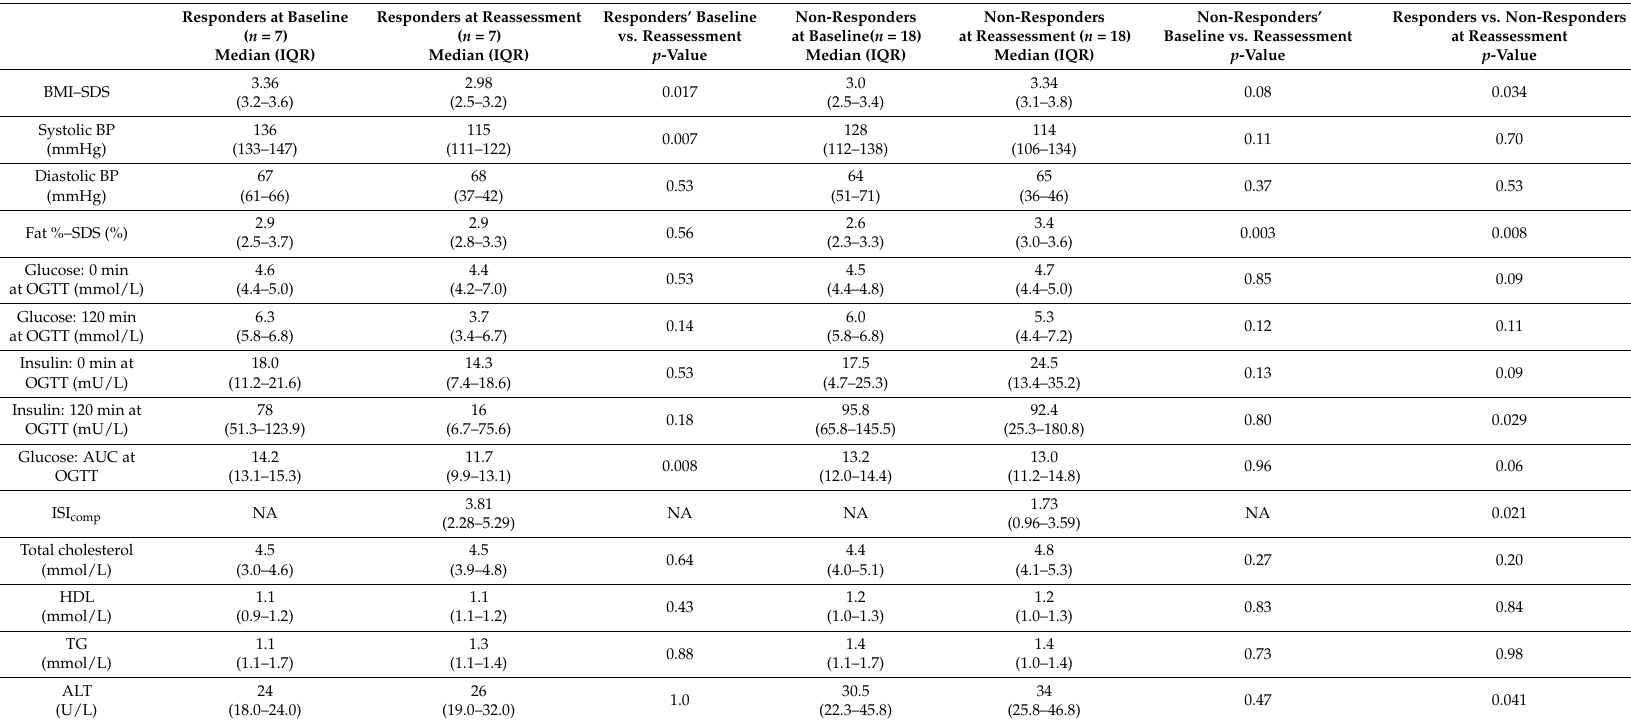
Table 1. Metabolic markers of responders baseline vs. reassessment responders vs. non-responders at